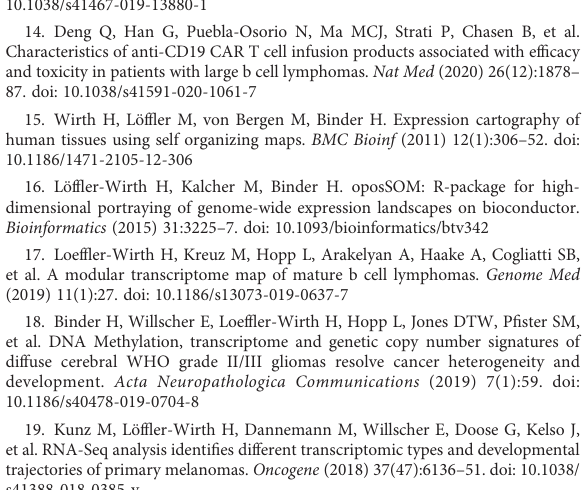
SUPPLEMENTARY TABLE 1 Patient characteristics. SUPPLEMENTARY TABLE 2 Number of genes associated to the expression modules and number of cells with module expression exceeding one standard deviation. SUPPLEMENTARY TABLE 3 T cell subpopulations assigned using the consensus marker scheme. Poly-functional cells are counted multiply. SUPPLEMENTARY TABLE 4 Regression analysis of ICANS